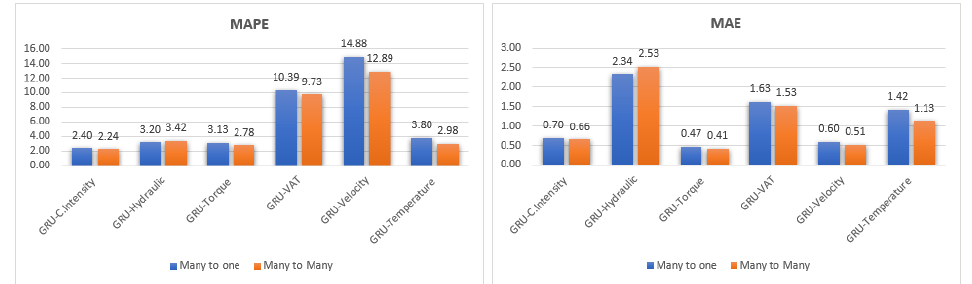
Figure 17. Comparison of the performance of the GRU models, trained to predict many-to-many and many-to-one variables.